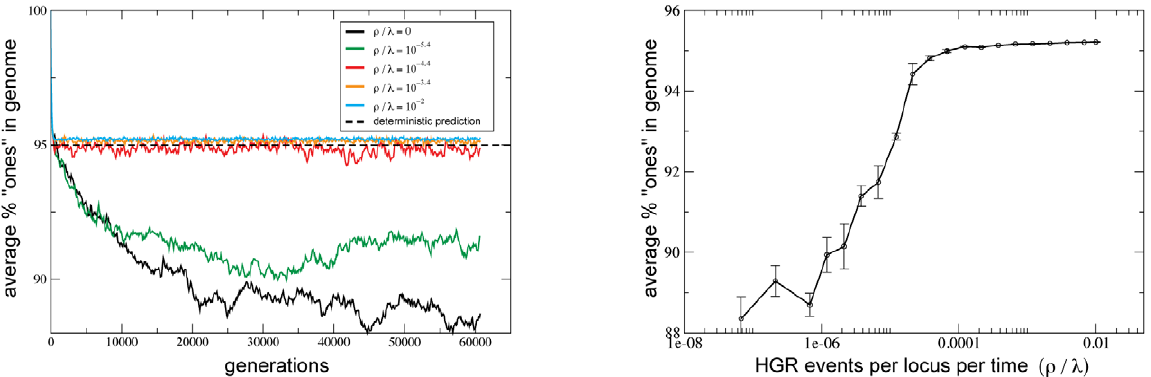
Figure 3. HGR increases equilibrium fitness. Recurrent deleterious mutations are predicted to decrease the number of ones by & 5% in infinitely large populations. In these finite populations we see an additional cost of & 7% when HGR is absent. HGR restores the average fraction of ‘‘ones’’ to the deterministic ( N ? ? ) prediction (see main text). Averages were taken over the final 15,000 generations and 5 replicates. Error bars denote one standard error. Parameters are the same as in figure 2. See figure S5 for behavior with lower mutation